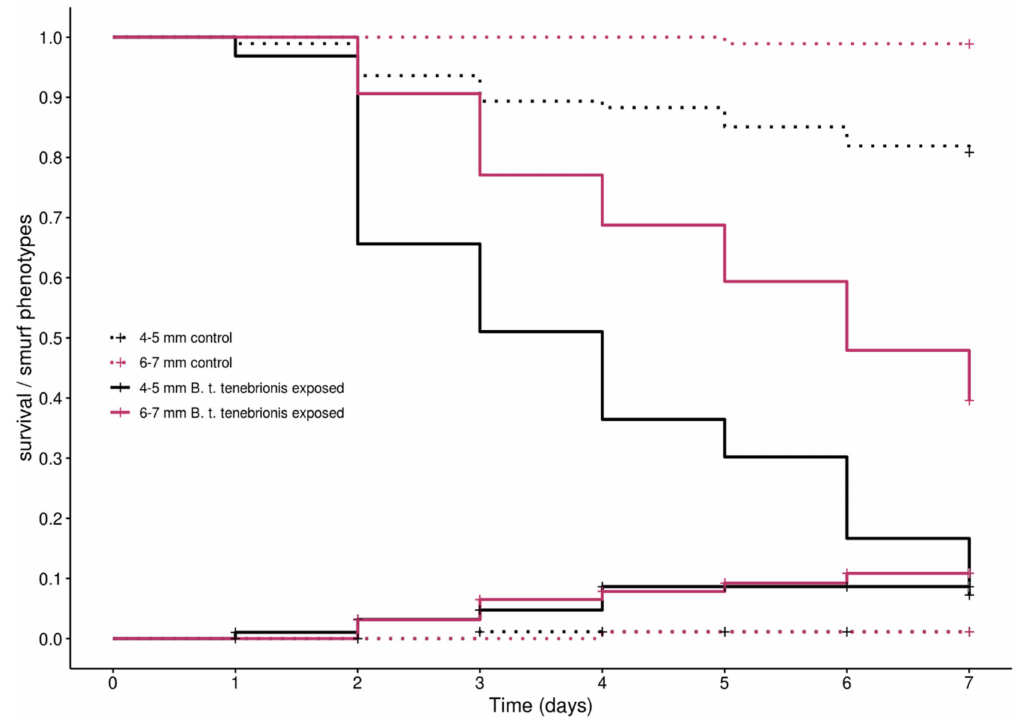
Figure 3. Survival and occurrence of Smurf phenotype in small and large larvae of T. molitor during exposure to B. thuringiensis tenebrionis . Kaplan-Meier curves representing the survival (descending curves) and the cumulative incidence of Smurf phenotypes (ascending curves) in T. molitor larvae of 4–5 mm (in pink) or larvae of 6–7 mm (in black) when exposed to a control diet (dashed lines) or